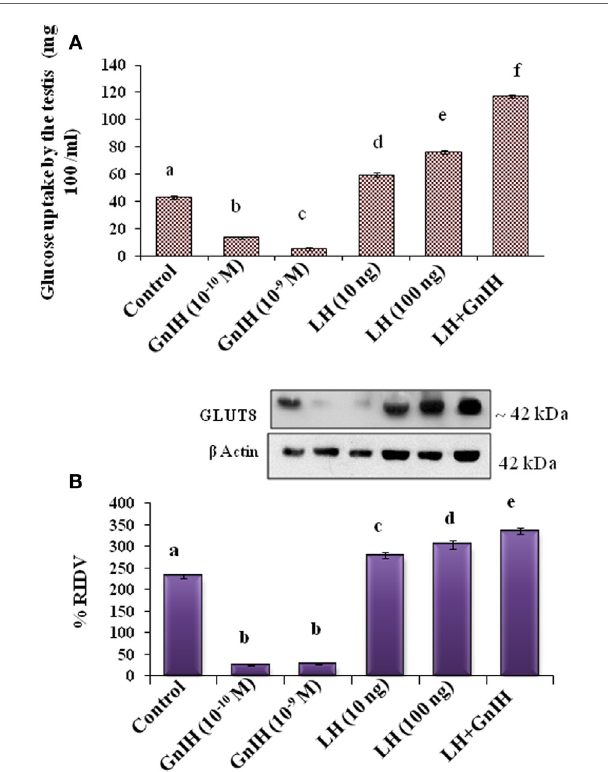
FigUre 4 | The in vitro treatment of different doses (10 − 10 and 10 − 9 M/ ml) of gnih with or without different doses (10 and 100 ng/ml) of lh showed effect on glucose uptake by the testis and expression of glUT 8 protein. (a) The treatment with low and high doses (10 − 10 and 10 − 9 M/ml) of GnIH showed a dose-dependent suppression of glucose uptake in the testis. The treatment with low and high (10 and 100 ng/ml) doses of